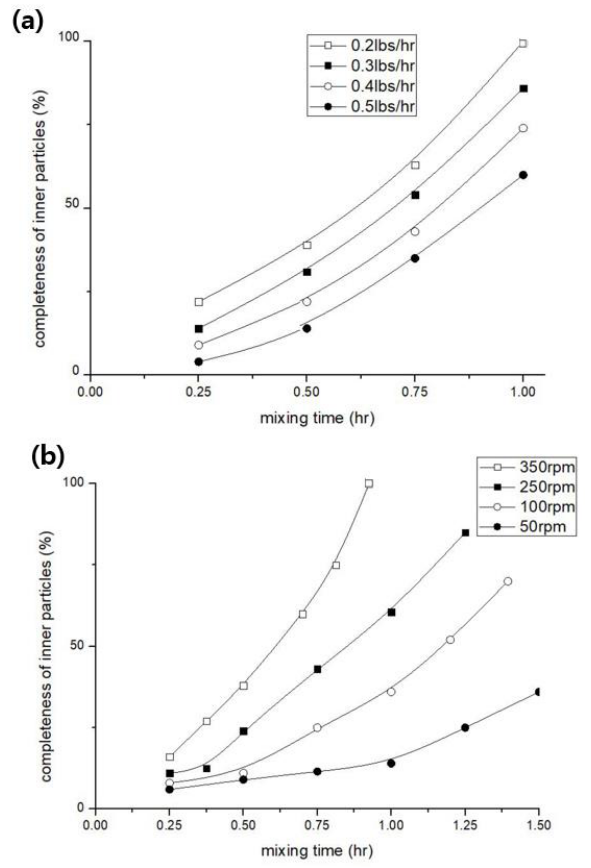
Figure 4. Comparison of tungsten input volume and mixing time based on injection molding machine conditions. ( a ) Mixing time based on the volume of tungsten per hour, ( b ) tungsten mixing time based on the screw rotational speed.